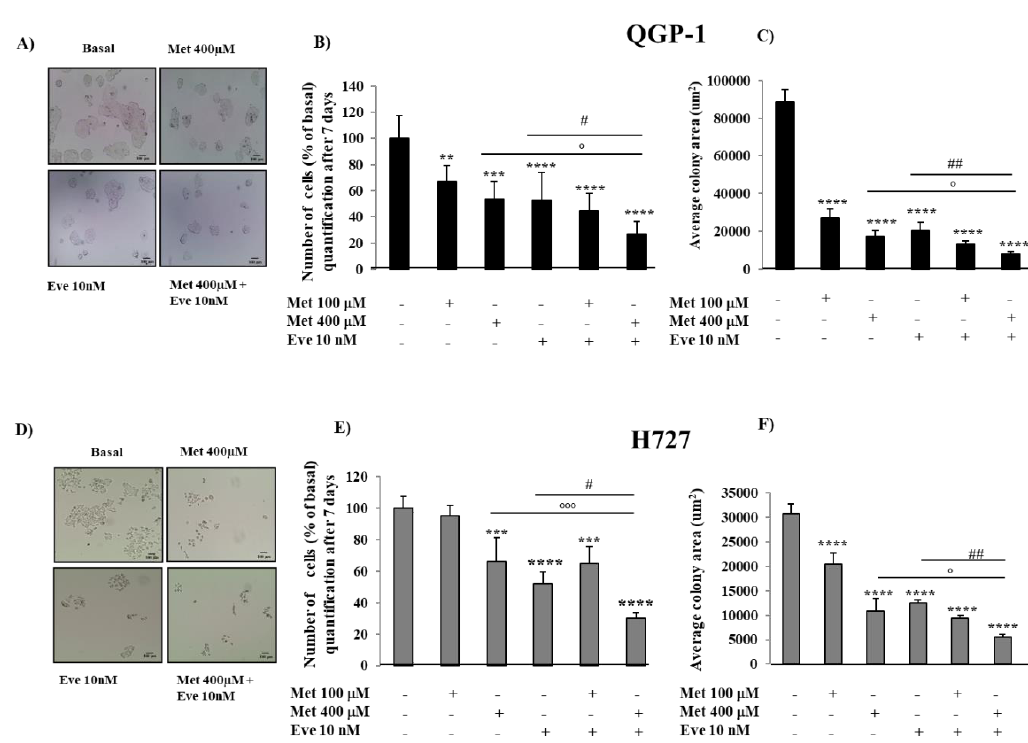
Figure 3. The effect of metformin (Met) and everolimus (Eve) on QGP-1 and H727 colony formation. ( A , D ) QGP-1 and H727 cells incubated with or without metformin 400 µM, everolimus 10 nM or with their combination. Microscopy images show that the combination of metformin and everolimus strongly decreased QGP-1 and H727 cell number and colony size. Scale bar 100 μm . ( B , E ) To count the number of cells, after metformin treatment (100 µM and 400 µM) and everolimus (10 nM), alone or in combination, for 7 days, QGP-1 and H727 cells were incubated with the CyQUANT ® GR dye and fluorescence was measured at 480/520 nm. The graph shows that the metformin and everolimus combination is more effective than each monotherapy in decreasing the number of QGP-1 and H727 cells. Values represent mean ± SD of at least 3 experiments. ** = p < 0.01, *** = p < 0.001 **** = p < 0.0001 vs. corresponding basal, ° = p < 0.05 and °°° = p < 0.001 the combination vs. metformin, # = p < 0.05 the